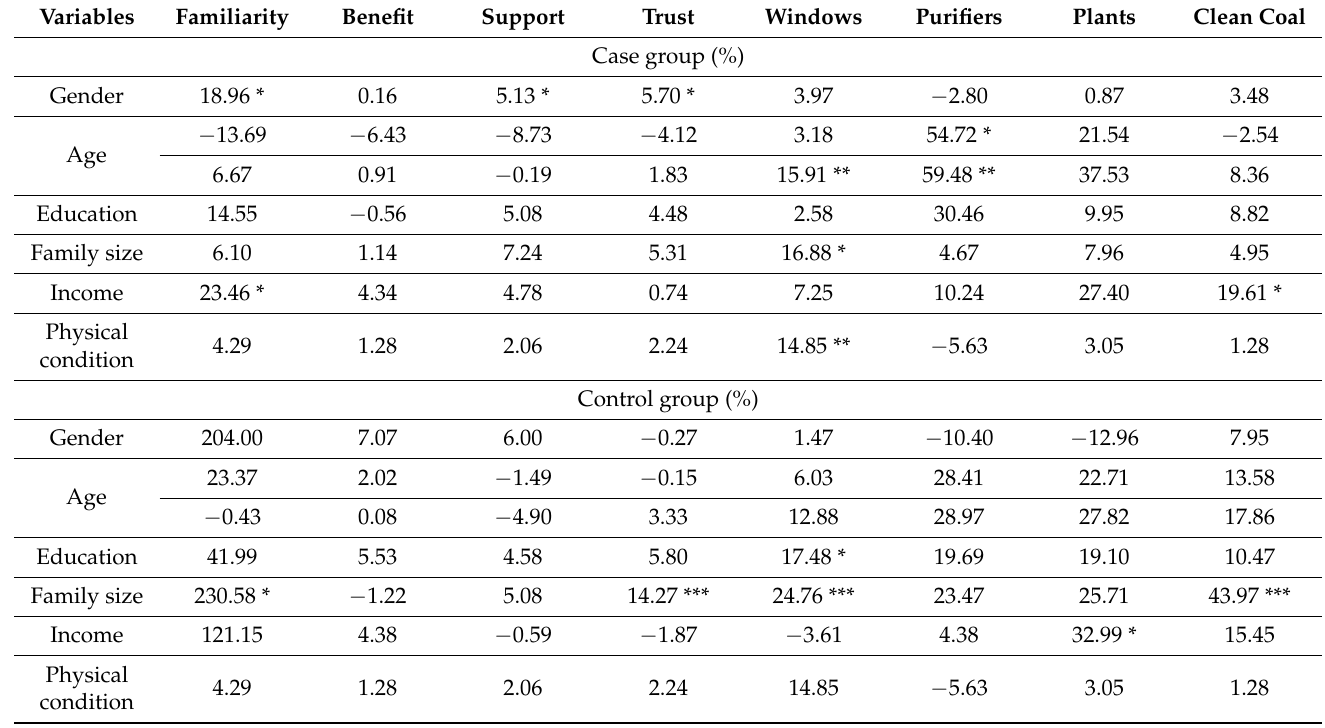
Table 4. Comparison of risk perception and self-protective willingness among different demo- graphic groups 1